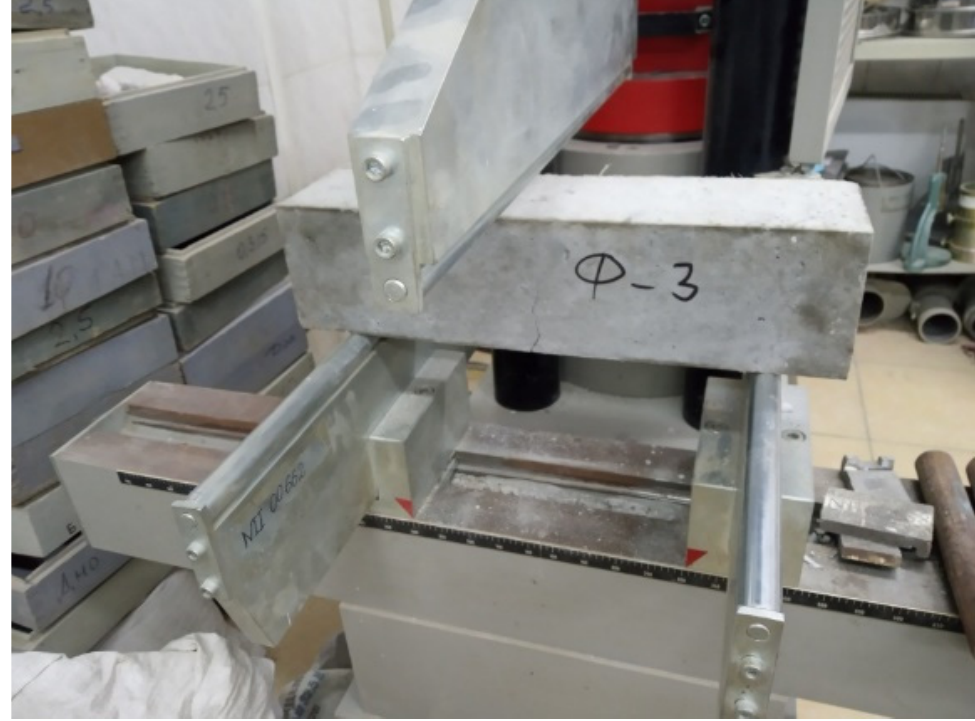
Figure 1. Beam flexural test.